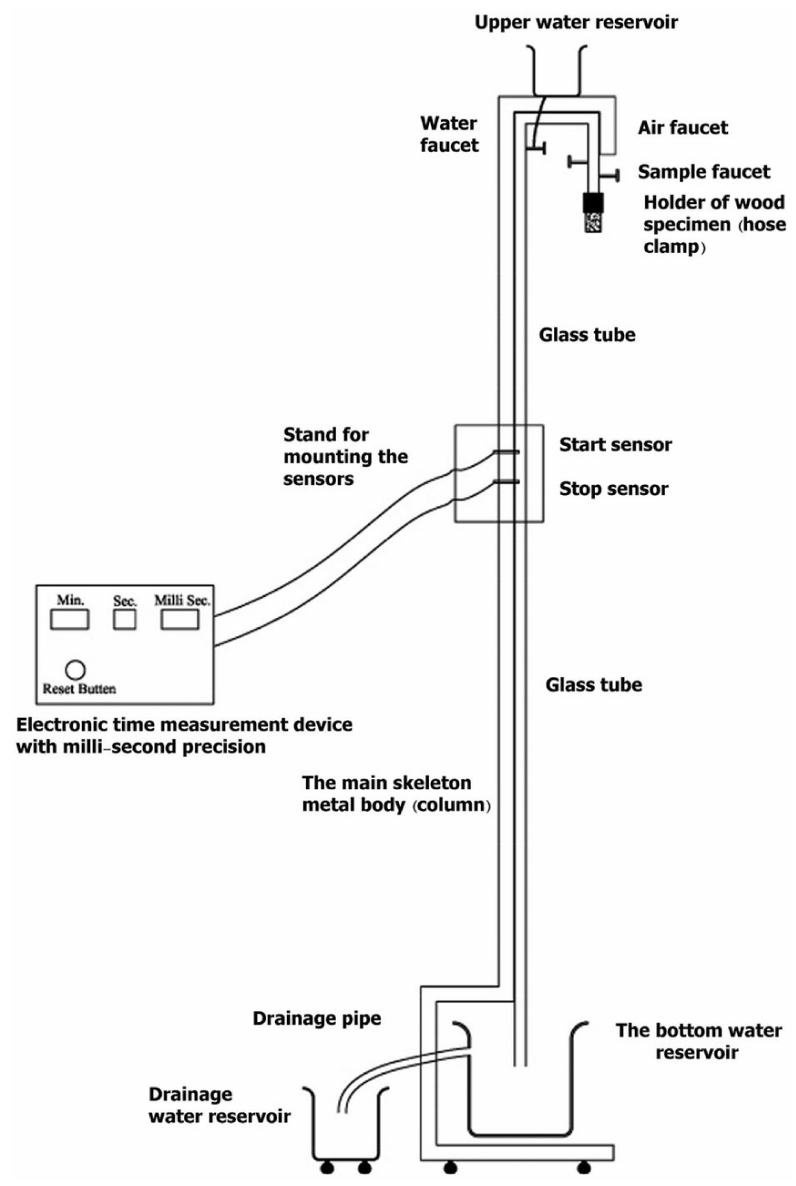
Figure 1. Schematic representation of the gas permeability apparatus equipped with single-story milli-second precision electronic time measurement device